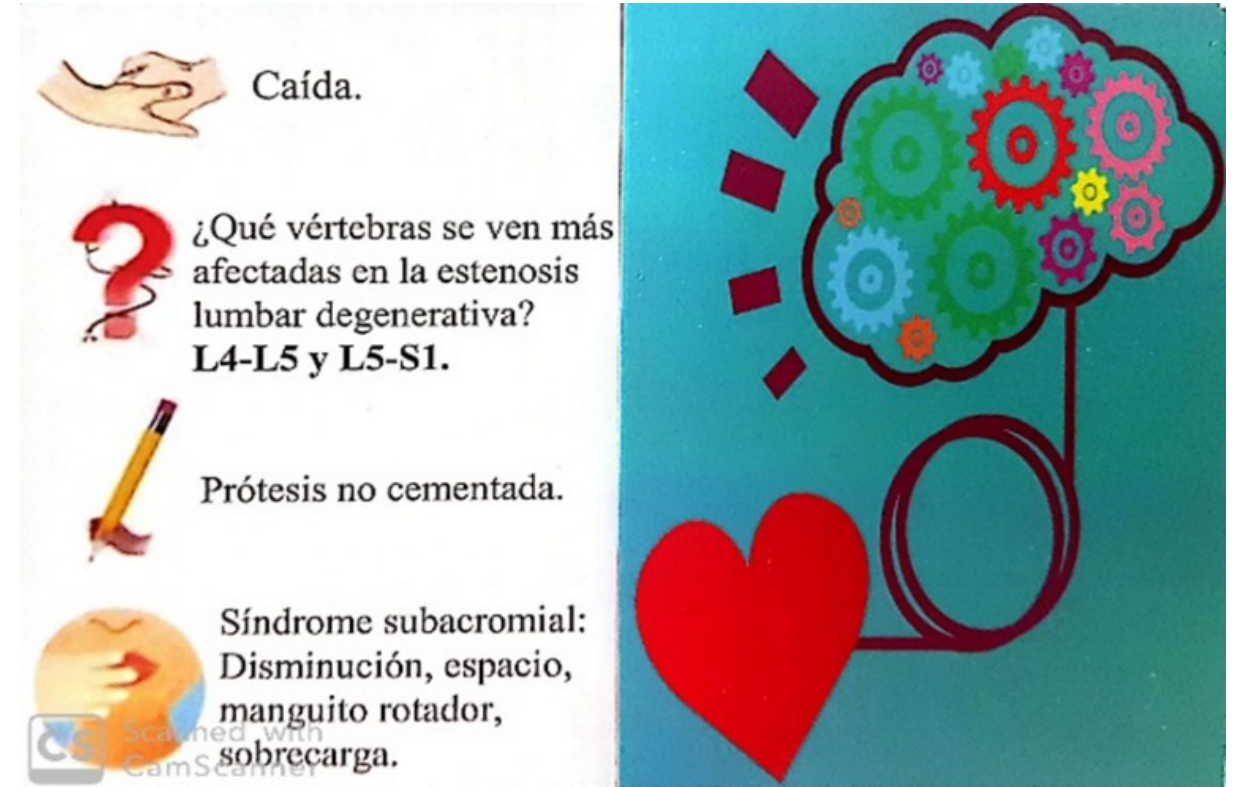
Figure 3. Card used in the